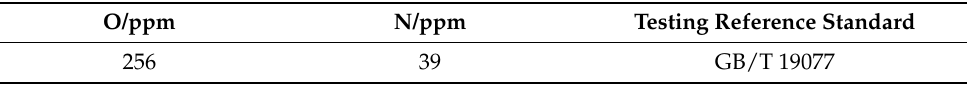
Table 2. Nitrogen and oxygen content of 24CrNiMo alloy steel